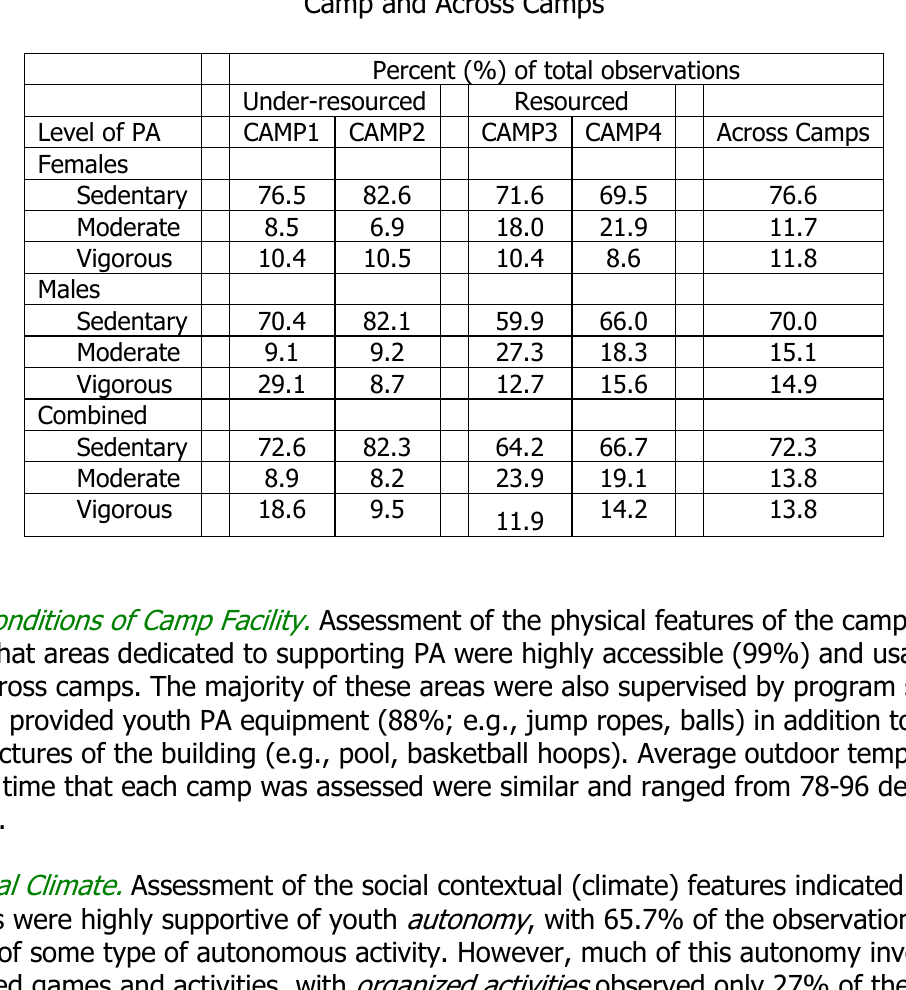
Percentage of Observed Instances Spent in Moderate-to-Vigorous Physical Activity for